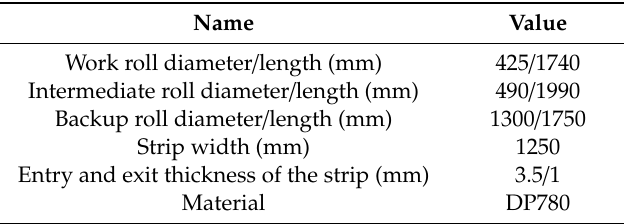
Table 2. The rolling parameters for the simulation.